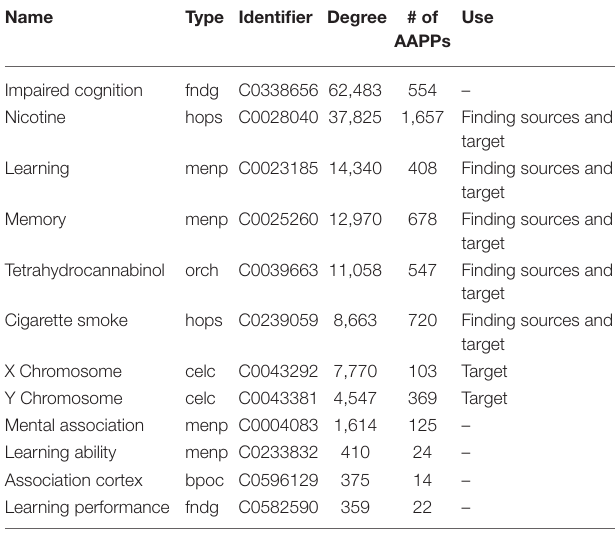
TABLE 1 | List of target nodes considered and/or used for the presented SemNet use case to “assess the the differential impact of smoking on cognition in men and